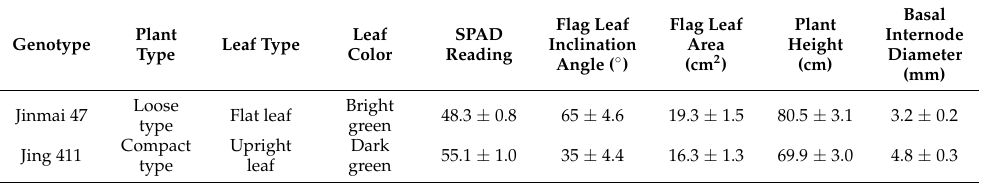
Table 2. Plant architecture attributes of the genotypes Jinmai 47 and Jing